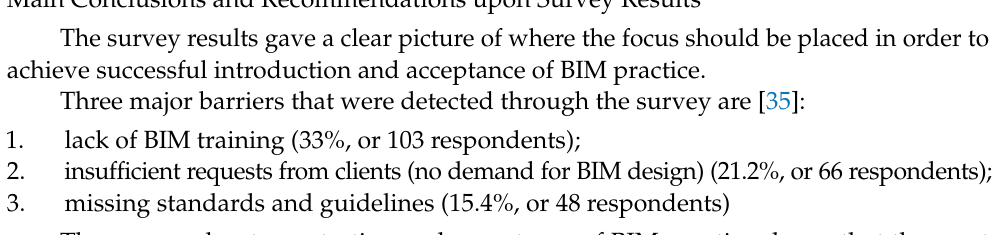
Figure 6. Barriers for BIM adoption identified during the BIM survey in North Macedonia [34].